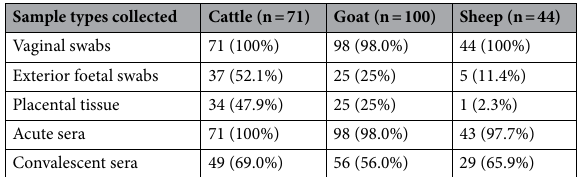
Sample types collected